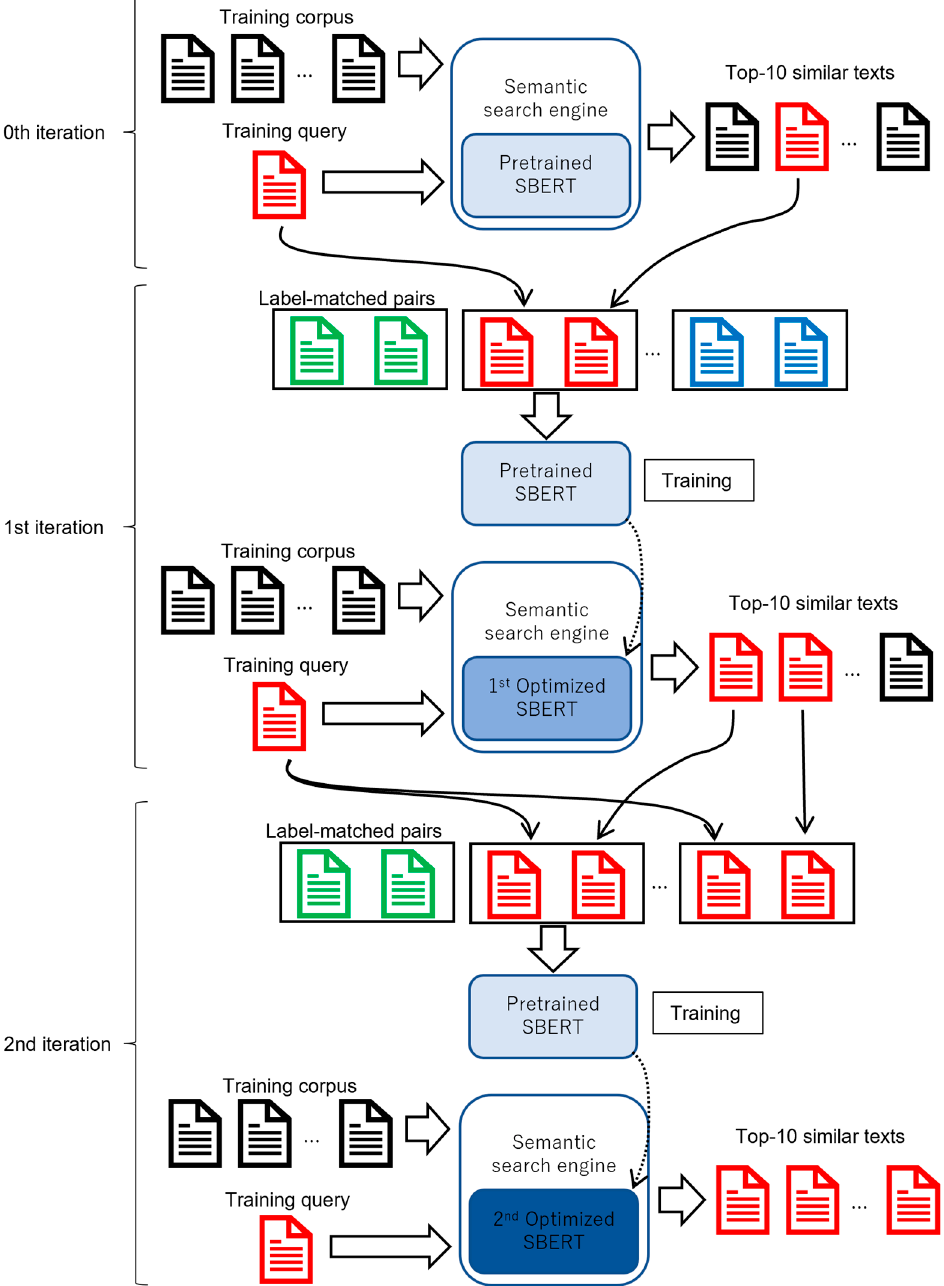
Figure 4. The SBERT iterative optimization method. Documents of the same color indicate that the labels are an exact match.